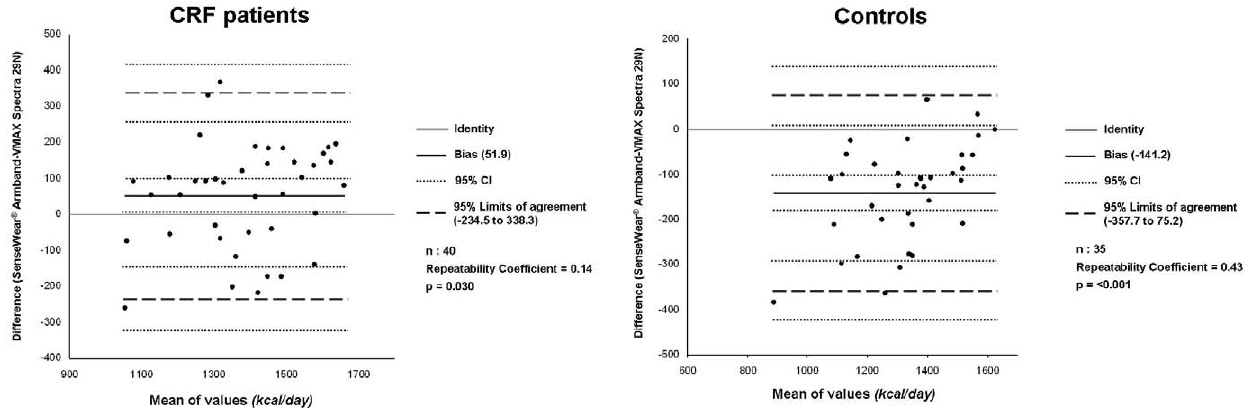
Figure 3. Bland & Altman analysis and repeatability coefficients in the two study groups.